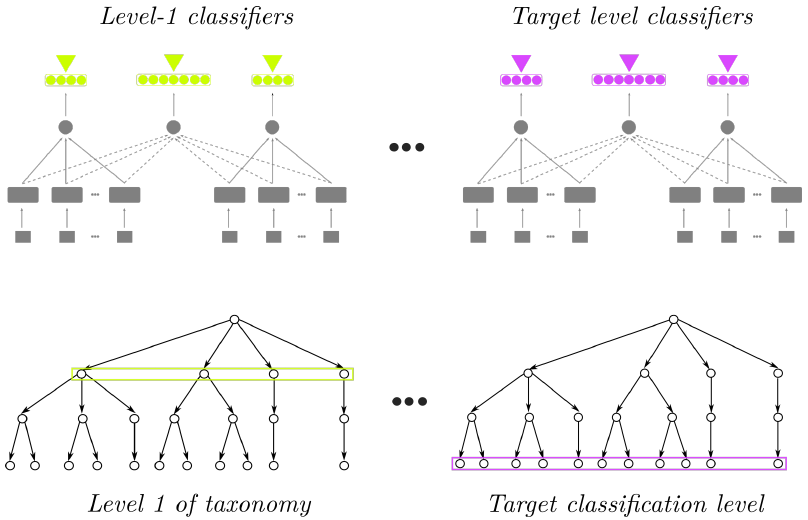
Figure 8. Overview of the hierarchical pretraining strategy adopted for HOb2sRNN